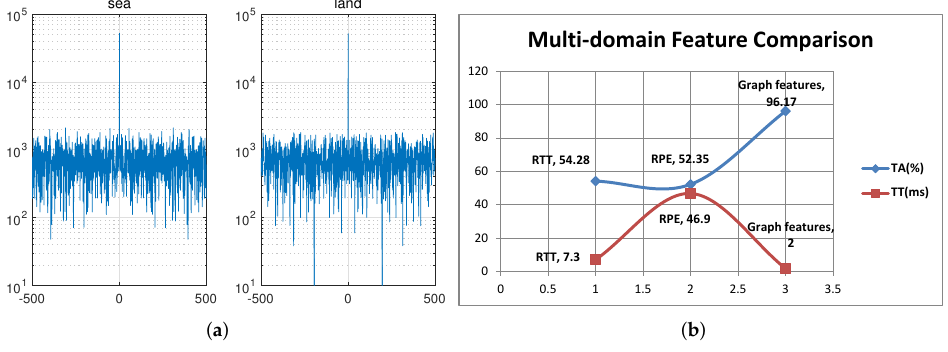
Figure 7. ( a ) Doppler amplitude spectra of sea and land clutter. ( b ) TA and TT of RTT/RPE/ Graph features combined with SVM.